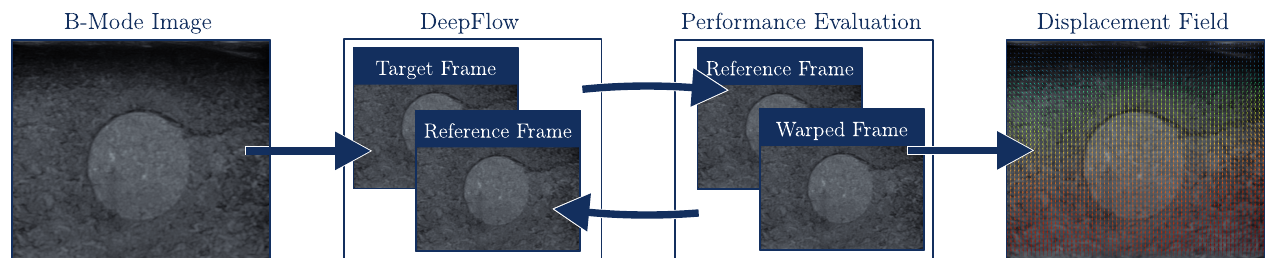
Figure 6. Displacement estimation with automatic redefinition of the reference frame.